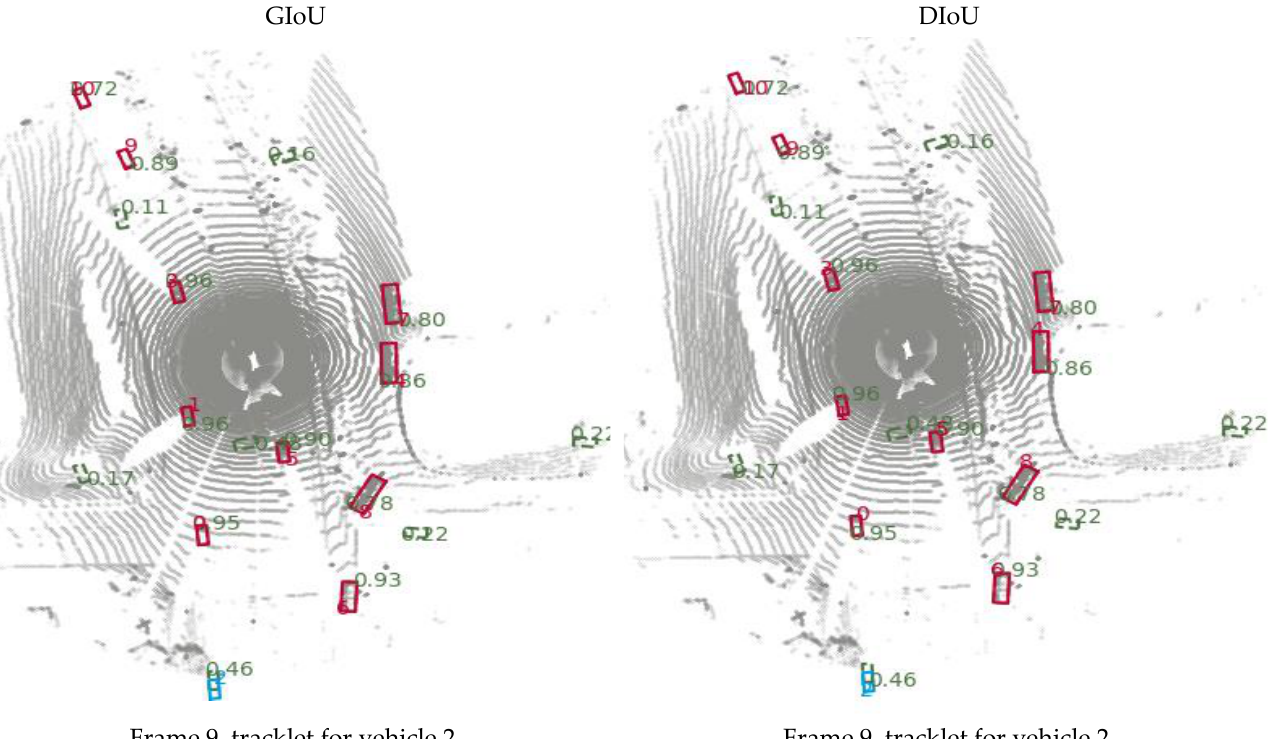
Frame 9, tracklet for vehicle 2.